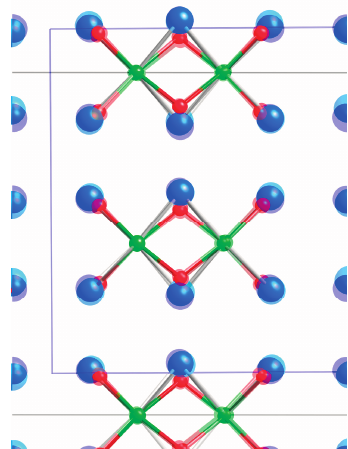
Figure 5. A projection of the Ba 3 AlAs 3 structure ( Cmce space group), shifted and overlaid on top of a projection of the Ba 3 GaAs 3 structure ( Pnma space group). Ba–Al and Ba–Ga bonds are drawn as grey cylinders to guide the eye. The blue spheres represent the Ba atoms, the green spheres denote the Al or Ga atoms, and the red ones are the arsenic atoms,